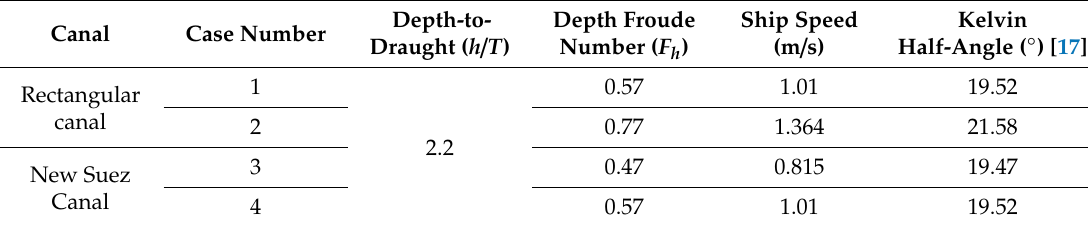
Table 2. Test matrix and resultant Kelvin half-angles according to Havelock’s [17]